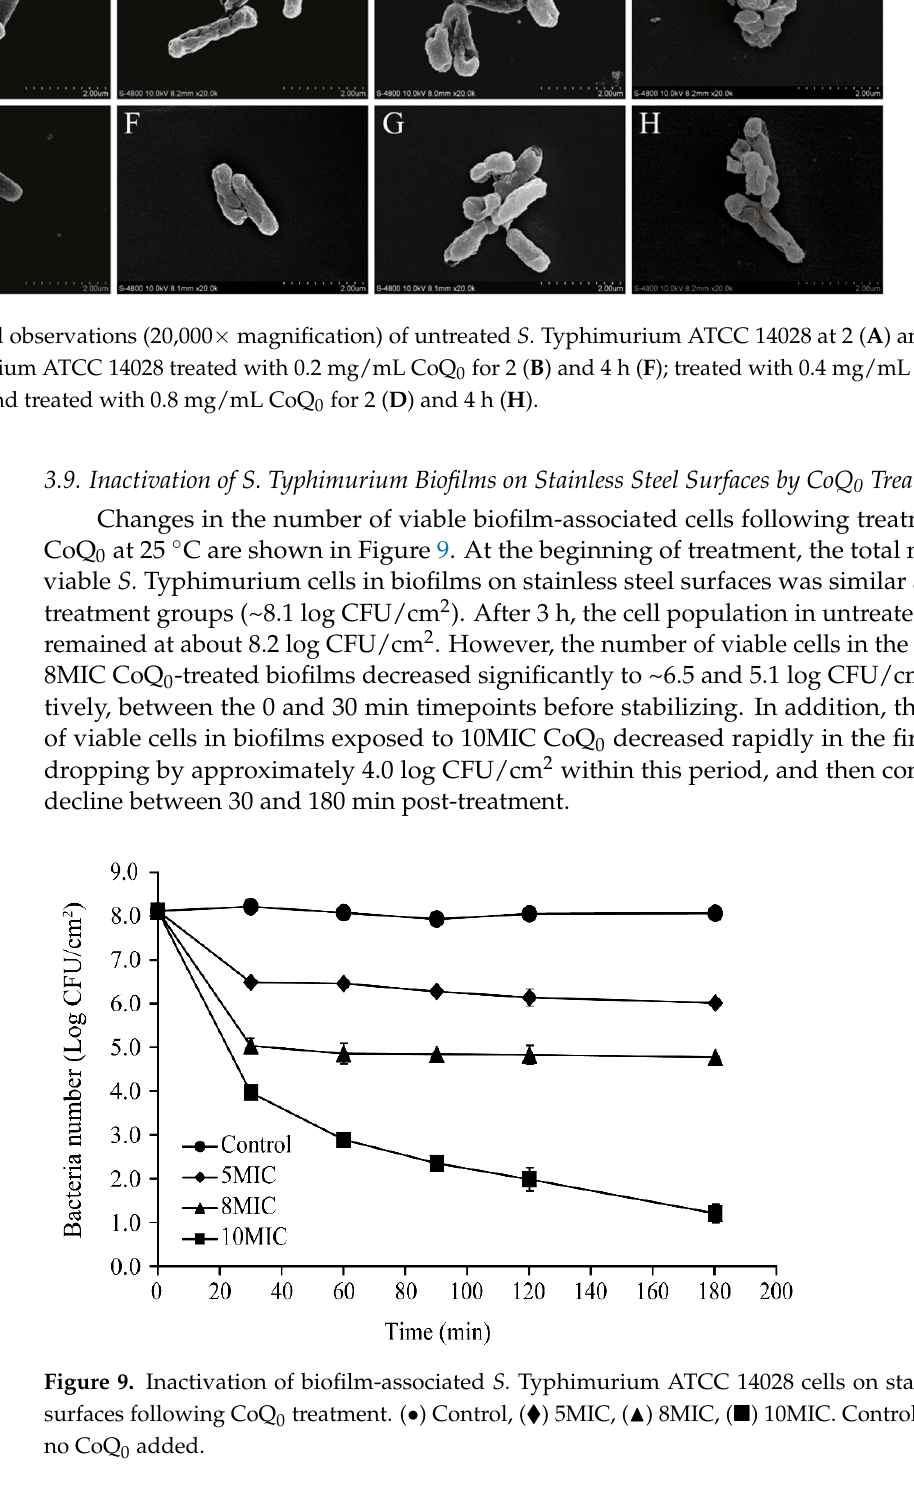
10 of 15 Figure 7. CLSM-based observation of changes in the membrane integrity of untreated S. Typhimurium ATCC 14028 cells ( A ) versus those treated with CoQ 0 at MIC ( B ) and 2MIC ( C ), as demonstrated by the proportions of green versus red fluorescence.